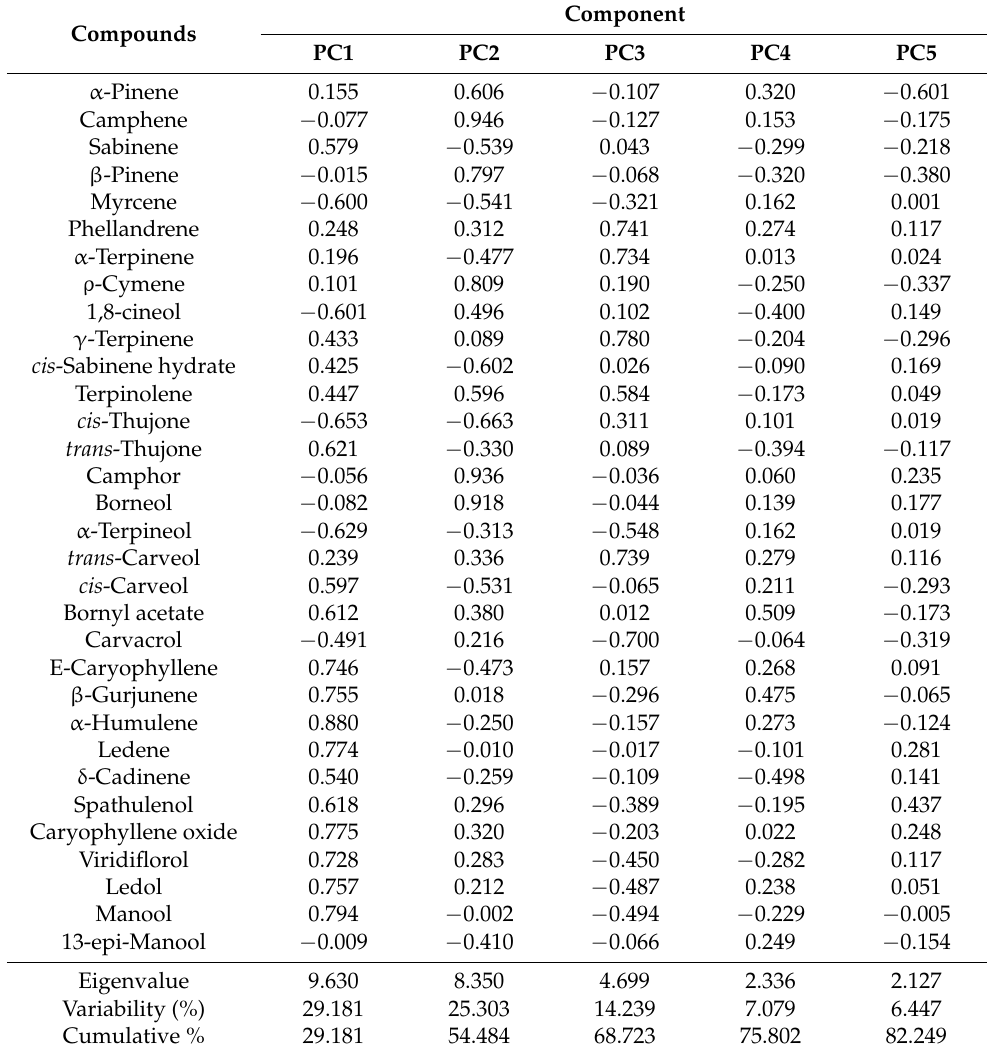
Table 3. Principal component analysis (PCA) of the main phytochemical compounds for different times of the day and night of S. officinalis